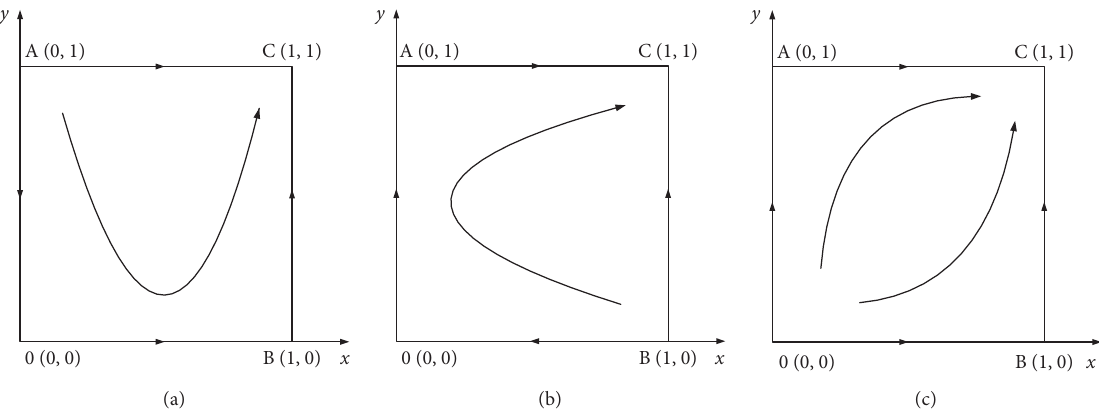
Figure 2: Evolutionary game phase diagrams (when point C (1, 1) is the ESS). (a) Situation IV. (b) Situation V. (c) Situation VI.